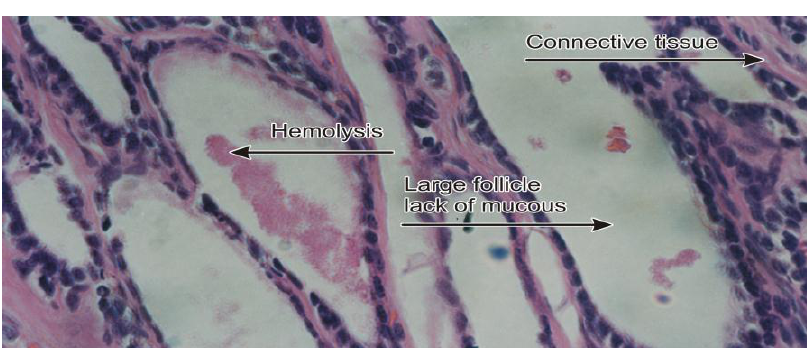
Figure – 2: Cross section from preputial gland in castrated rat showing decrease in connective tissue ( H&E stain, X40).